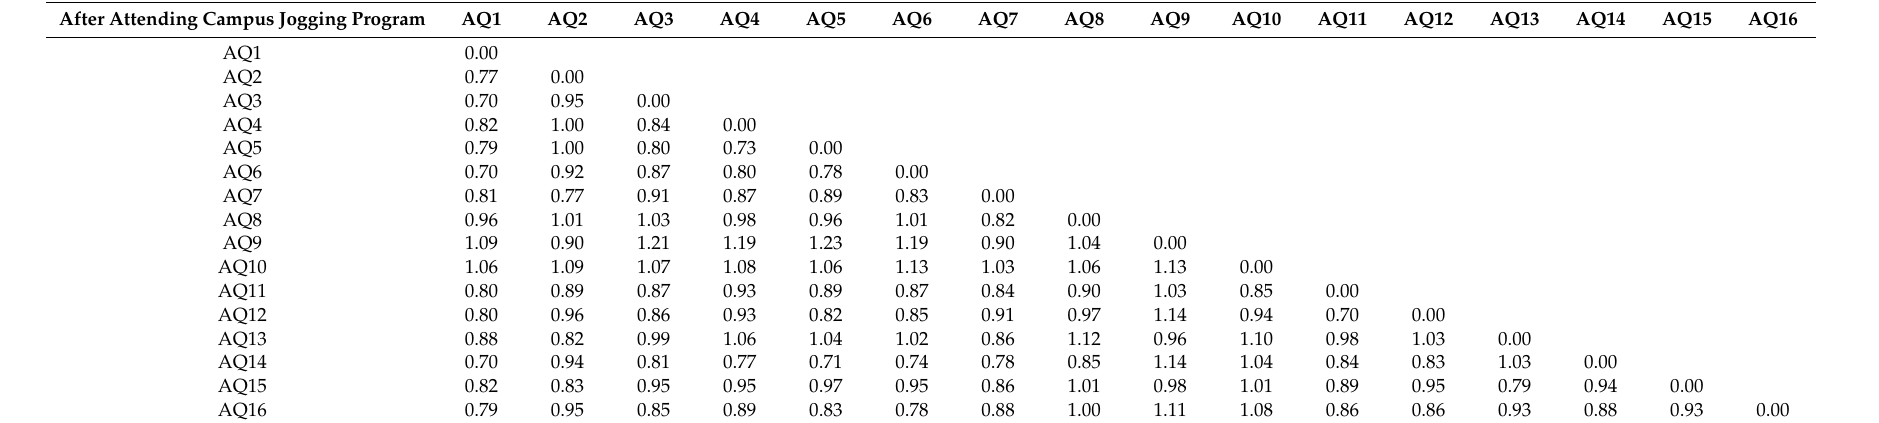
Table 5. Transformed proximities described by multidimensional scale (MS) after attending campus jogging program. After Attending Campus Jogging